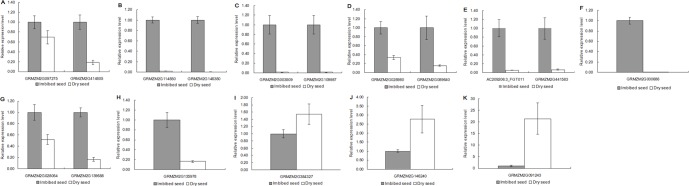
Quantitative RT-PCR analyses of the relative expression levels of various predicted target genes.The maize housekeeping gene actin was used as the internal control. The values presented were means of three technical replicates ± SD. A-K represented the expression profiles of some predicted target genes of miR156, miR164, miR166, miR167, miR168, miR169, miR319, miR393, miR408, miR528 and zma-miRn6 in dry and imbibed seeds, respectively.